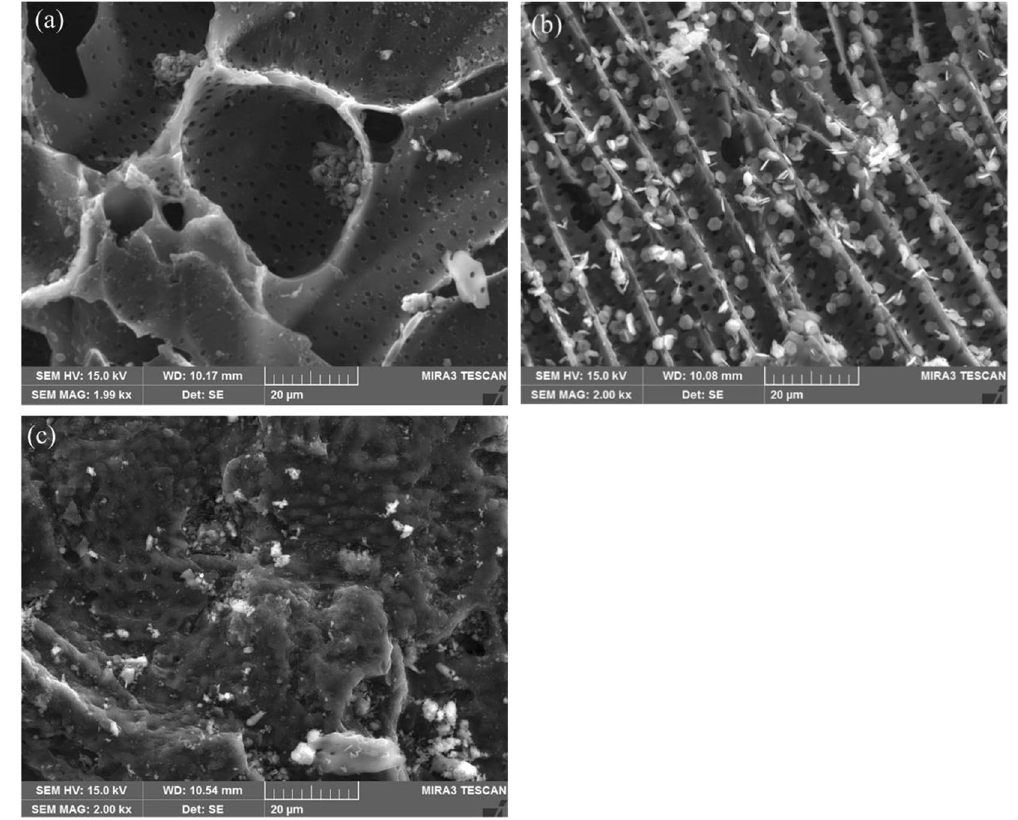
Figure 2. SEM images of ( a ) AC, ( b ) AC-Fe before EKR and ( c ) AC-Fe after EKR.